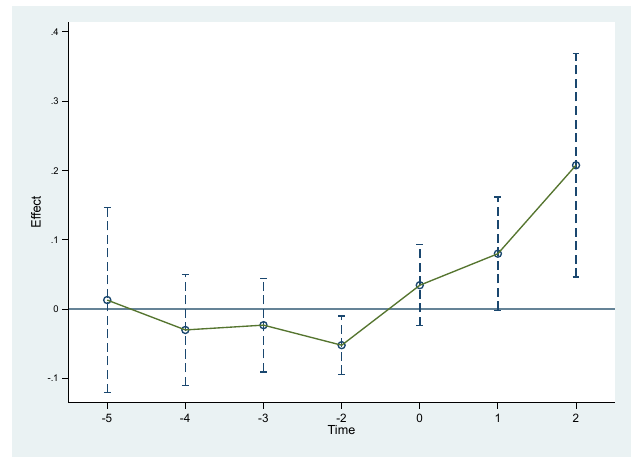
Figure 2. Parallel trend test of talent